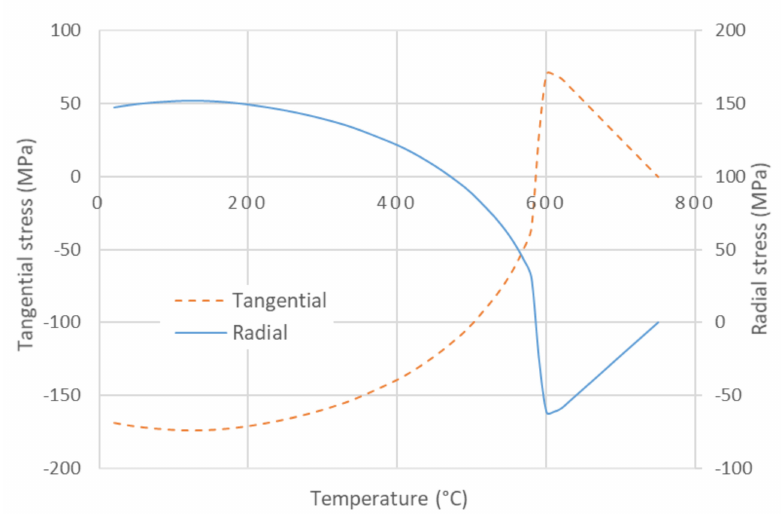
Figure 6. Development of the radial stress and the tangential stress on the quartz grain surface during cooling for 30% part of quartz in the double sphere model. The tensile stress has positive value, the compressive stress is negative.